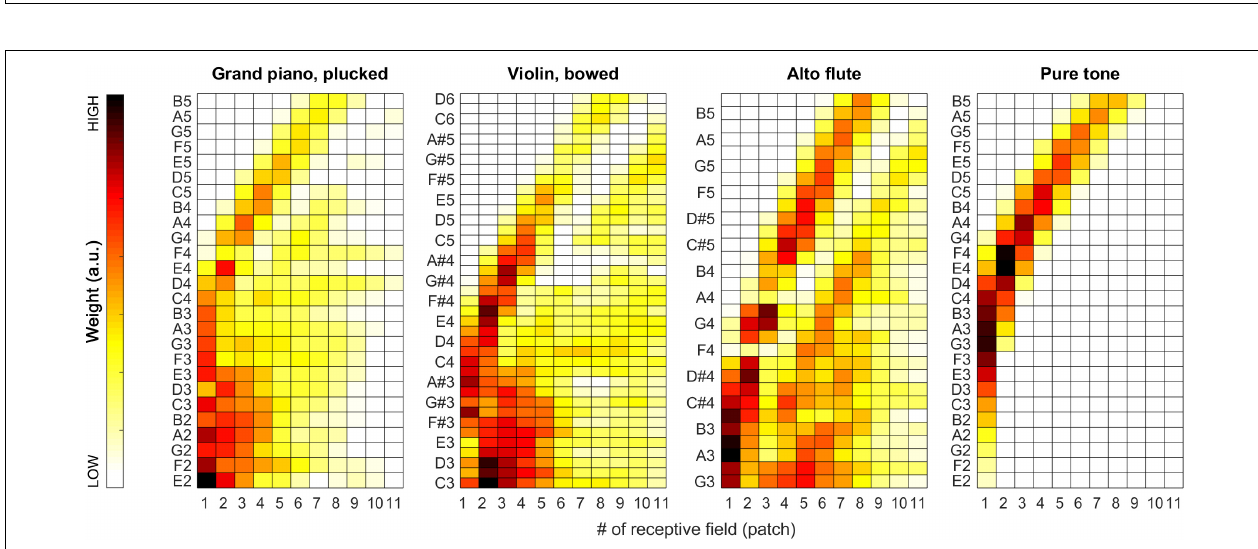
Frontiers in Neuroscience |